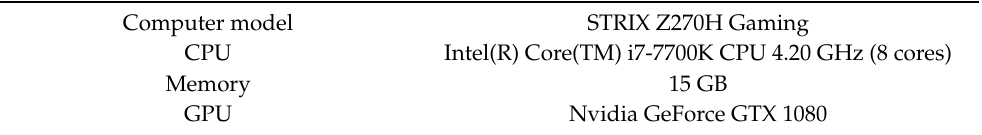
Table 4. Computer configuration applied in our experiments.